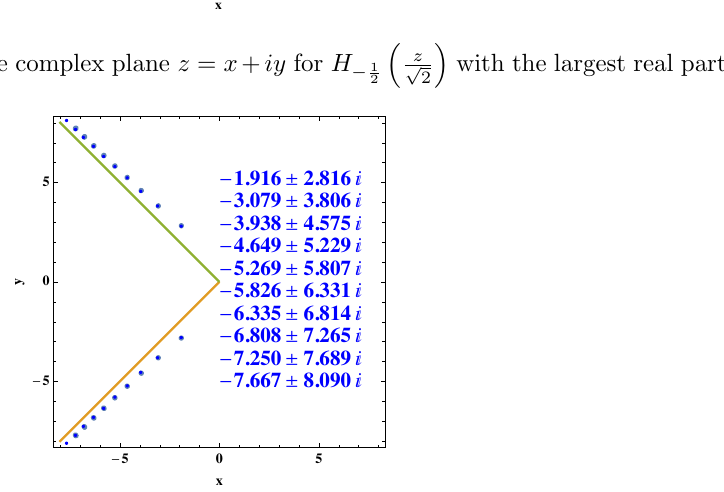
Figure 6 . The 20 zeroes on the complex plane z = x + iy for H